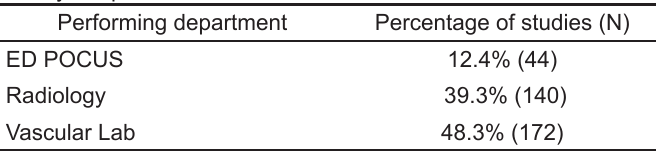
Table 1. Proportion of studies performed in each department to identify deep vein thromboses.